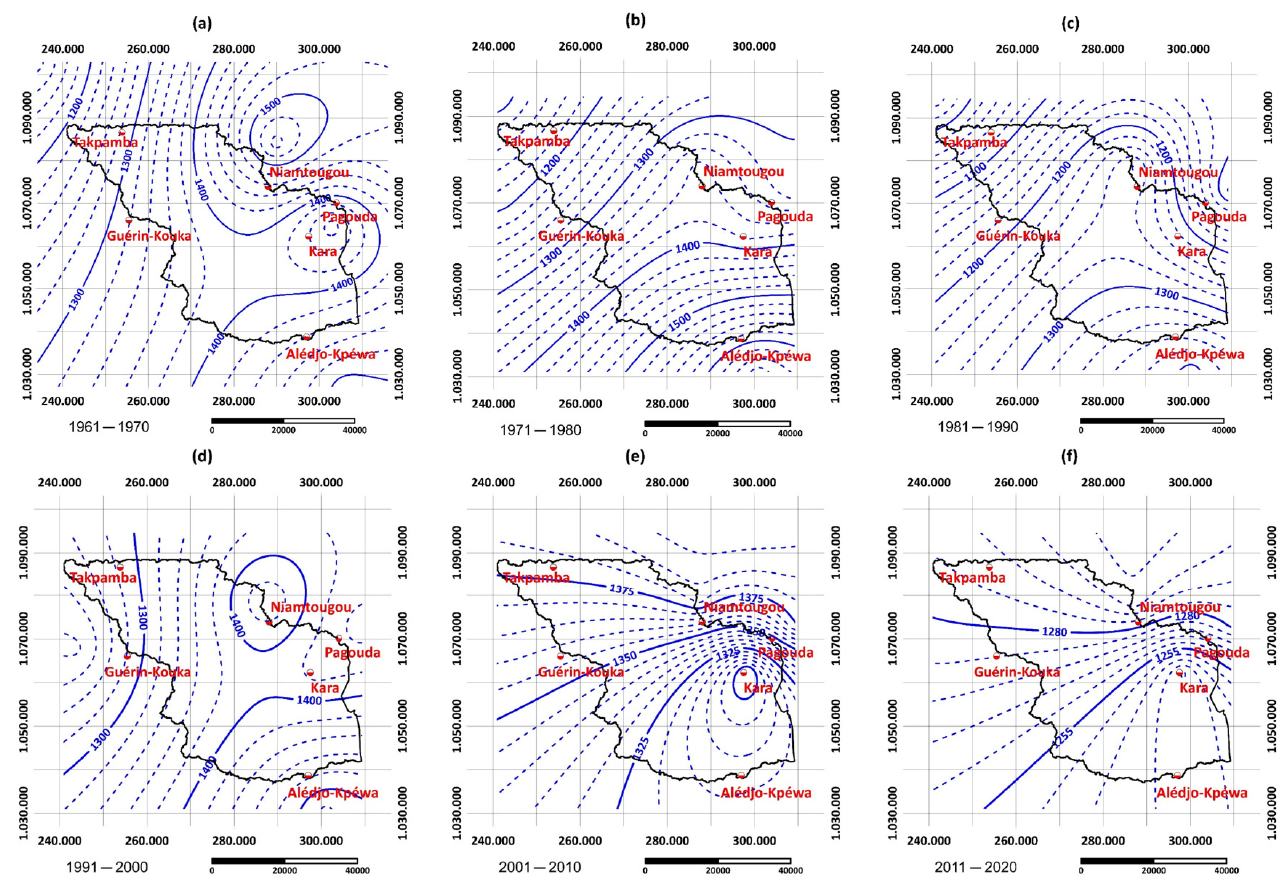
Figure 6. Spatial and temporal variation of decadal precipitation over the Kara River watershed during 1961 to 2020: ( a ) 1961–1970; ( b ) 1971–1980; ( c ) 1981–1990; ( d ) 1991–2000; ( e ) 2001–2010; ( f ) 2011–2020. The isohyets are represented by blue lines (the difference in precipitation levels between two isohyets varies according to the map).